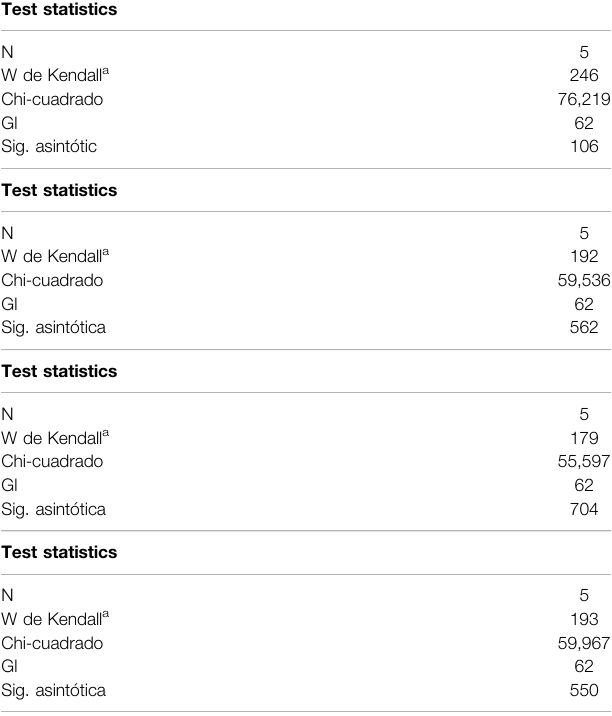
TABLE 1 | Kendall ’ s W test results for CL, RV, CH and PT criteria.